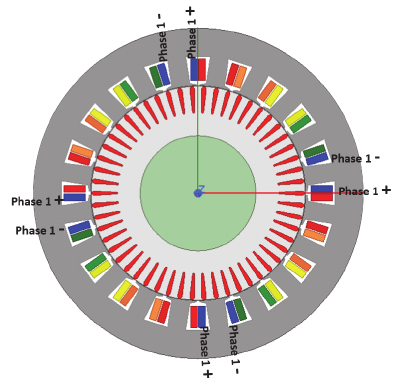
Figure A2. Geometry of the five-phase induction machine with double-layer tooth concentrated winding. Figure A 2. Geometry of the five ‐ phase induction machine with double ‐ layer tooth concentrated winding.